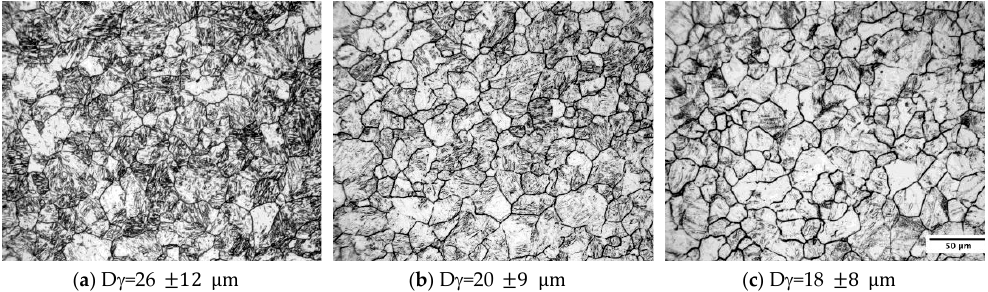
Figure 14. Mean austenite grain size after two passes with 15% reduction/pass at the respective